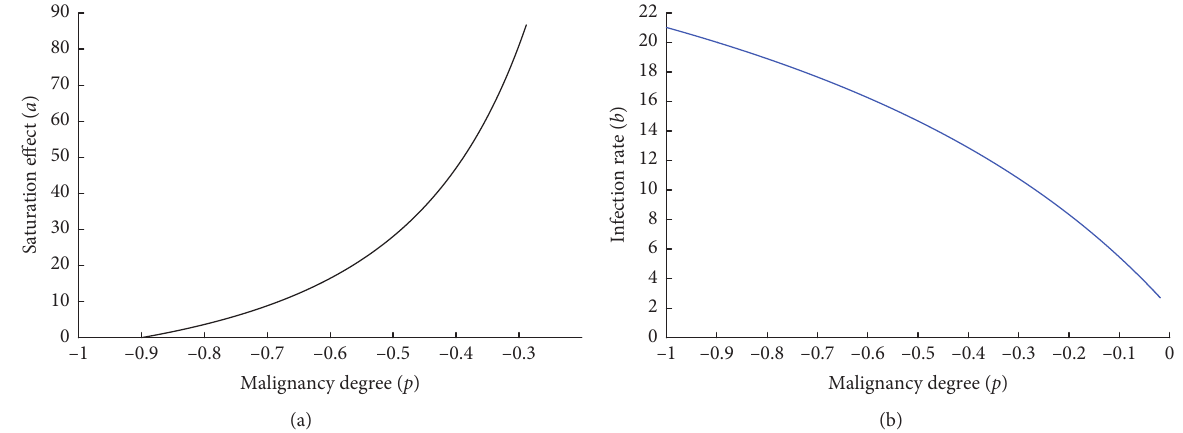
Figure 4: (a) Hopf curve when parameters p and a are varied simultaneously. (b) Hopf curve when parameters p and b are